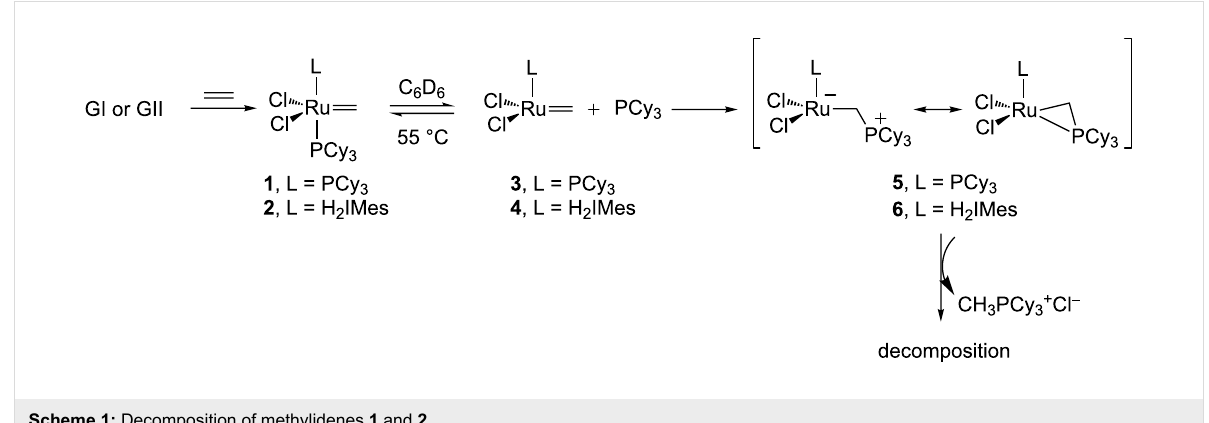
Scheme 1: Decomposition of methylidenes 1 and 2